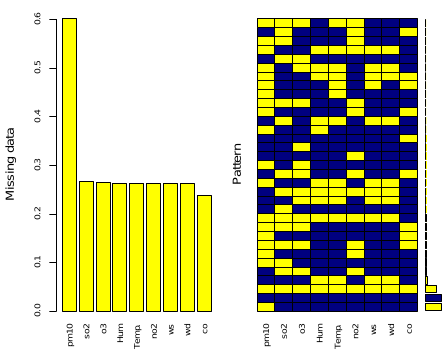
Figure A3. Missing value patterns for air quality measurements from 2012 to 2017. Left : Frequency of missingness in each variable. Right : Observed missingness patterns in the data set. The least frequent occurring patterns are located at the top of the plot, with gradually increasing frequency towards the bottom. Blue: observed, Yellow: missing.